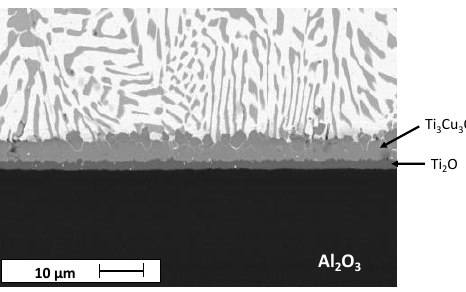
Fig. 19 -Cross-section of a CuAg-3at% Ti/Al 2 O 3 interface, after 30 minutes at 900°C in He. According to [40]. Figure 19. Cross-section of a CuAg-3 at% Ti/Al 2 O 3 interface, after 30 min at 900 °C in He. According to